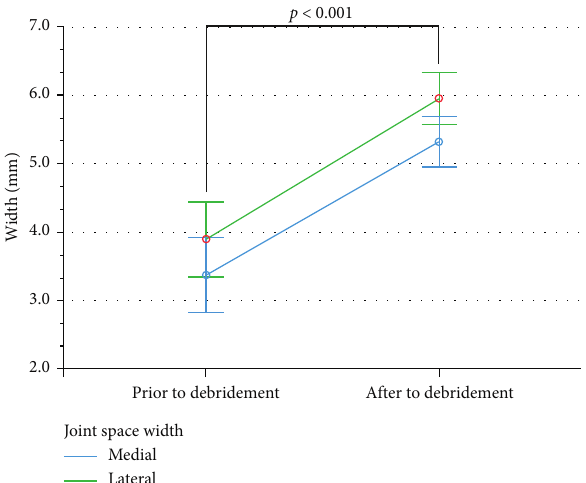
Figure 3: Tibiofemoral joint space width increase following the arthroscopic debridement of the inner retinaculum layer. The error bars correspond to the 95% confidence Table 2: Complications, symptoms, and satisfaction following 1 year of the intervention. Cases